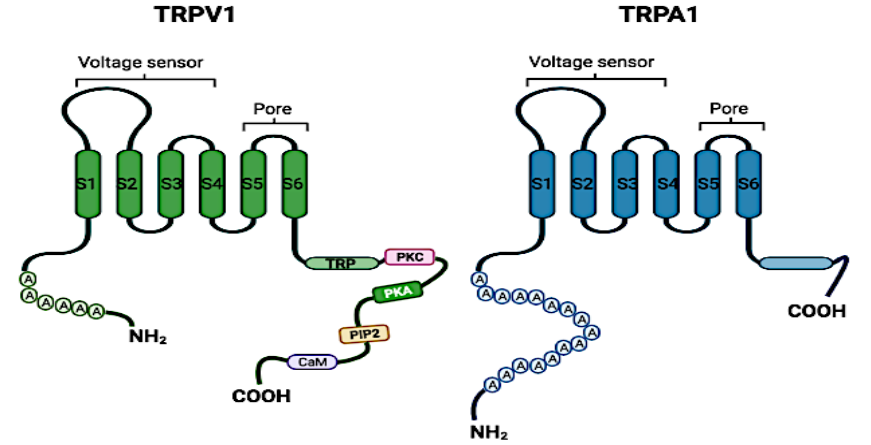
Figure 1. The structure of TRPV1 and TRPA1 channels. The general structure of these two channels includes six intracellular transmembrane domains (S1–S6), as well as carboxy (COOH), and amino (NH 2 ) terminals. TRPV1 and TRPA1 share 6 to 16 ankyrin repeats (A) at the amino terminus. Binding sites for protein kinase C (PKC), protein kinase A (PKA), phosphatidylinositol 4,5 bisphosphate (PIP2), and calmodulin (CaM) have been identified on TRPV1 channels. Created with BioRender.com, accessed on 28 June